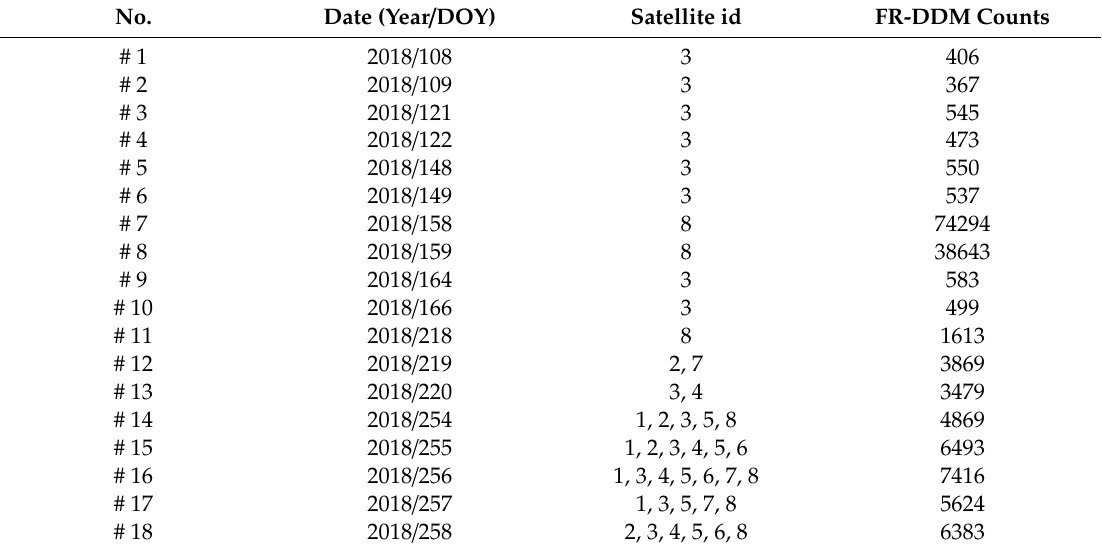
Table 2. List of collected Level 0 (L0) data.